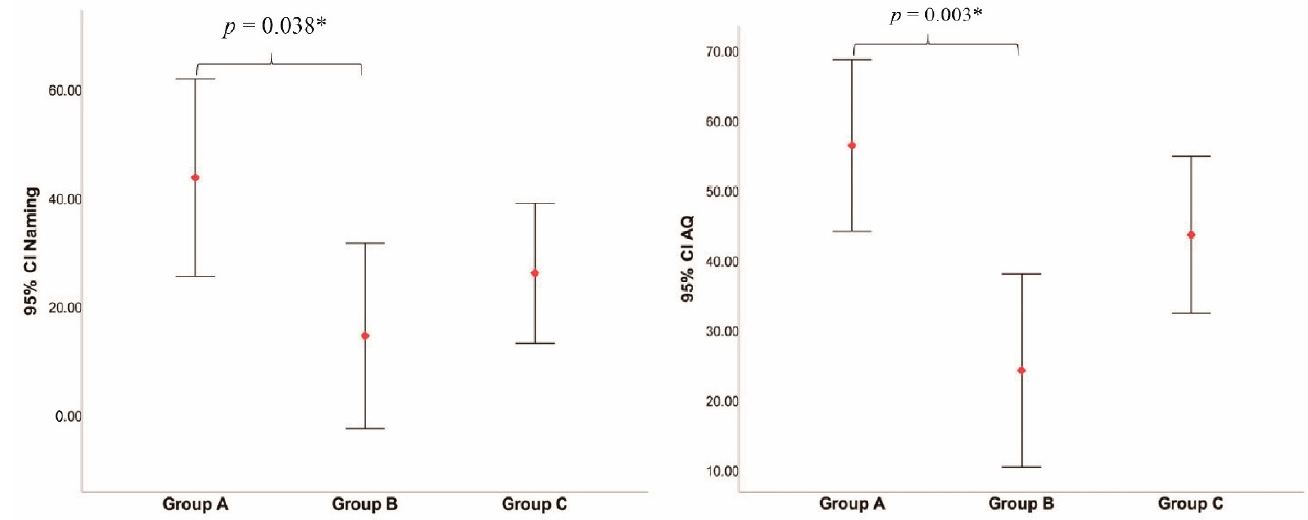
Figure 5. Multiple comparison tests for intergroup differences in language subsets. * Statistical significance level: α = 0.05.